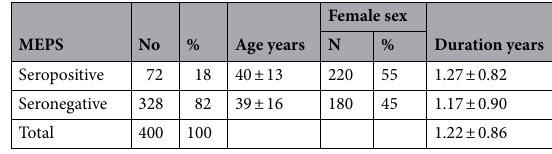
Table 1. Demographic data of MEPS study group.